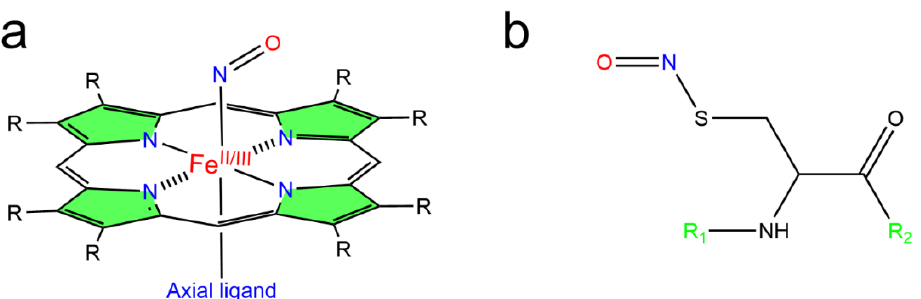
Figure 2. NO bound to an iron ion of a heme group ( a ) and to a Cys residue as nitrosothiol (SNO) ( b